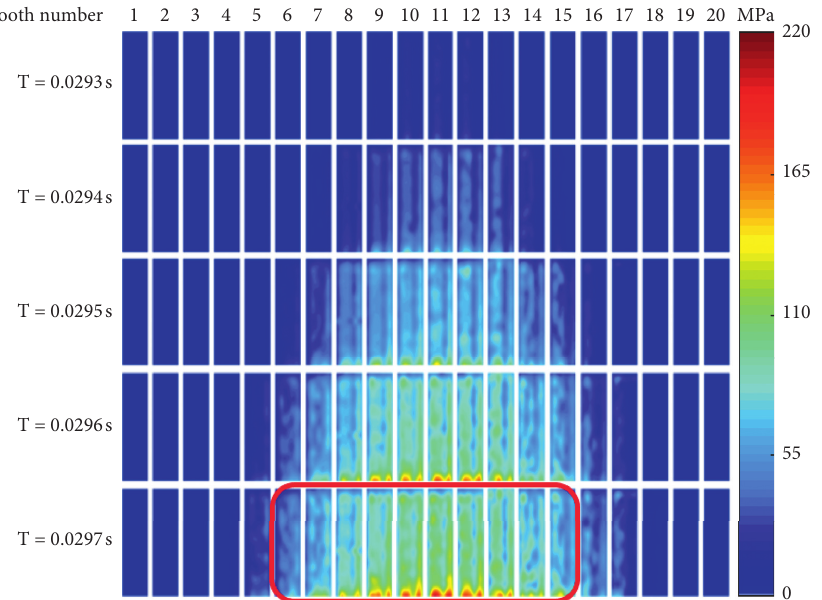
Figure 18: Real-time stress distribution of the contact area on axle spline surface under the identical loading case, at δ �